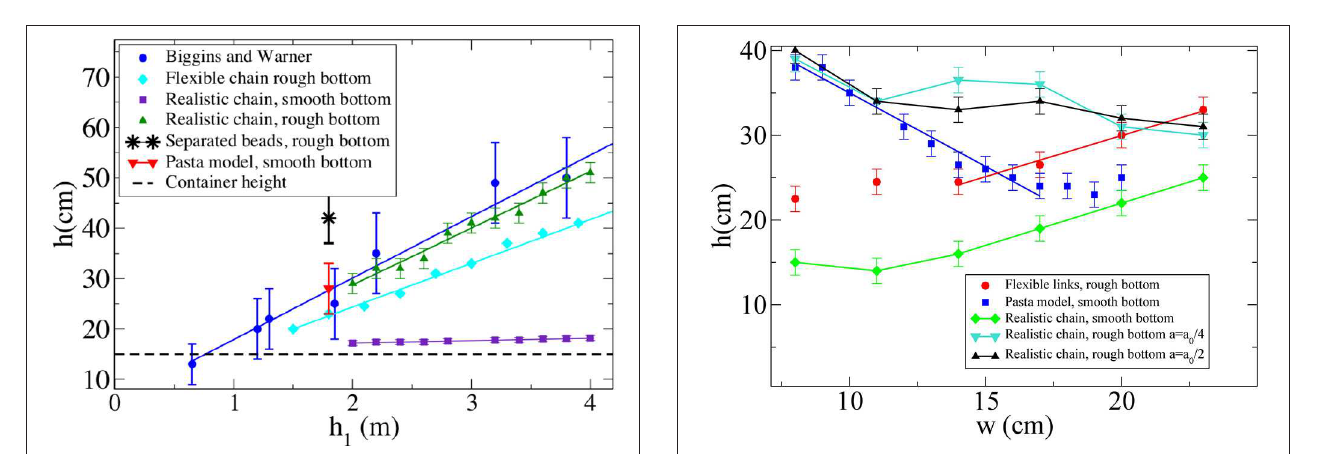
FIGURE 12 | Fountain height as a function of container width w h 1 = 2.5 m.